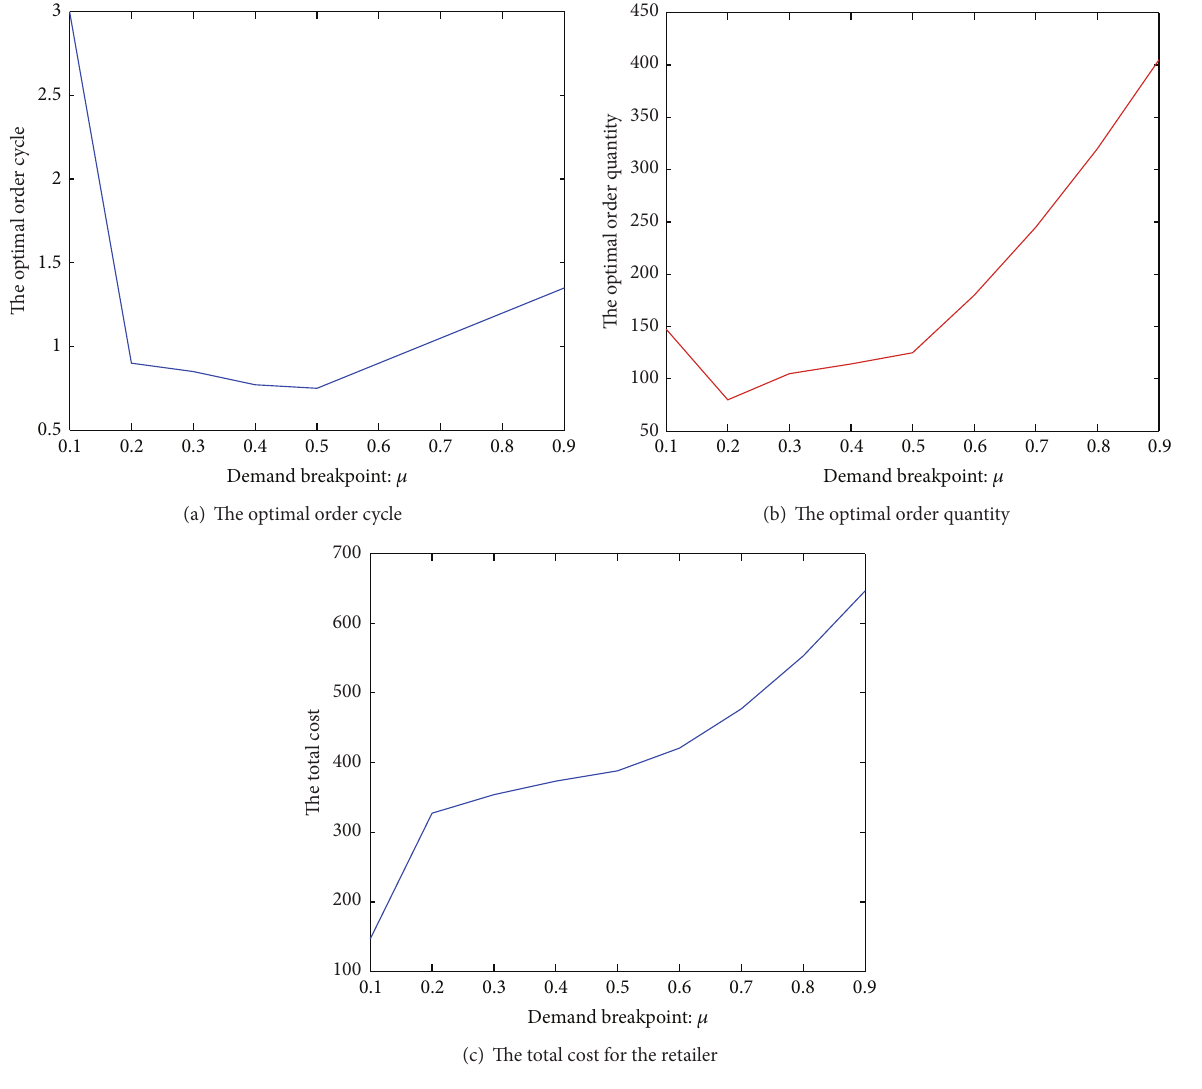
Figure 9: The impact of the changes of the parameter 𝜇